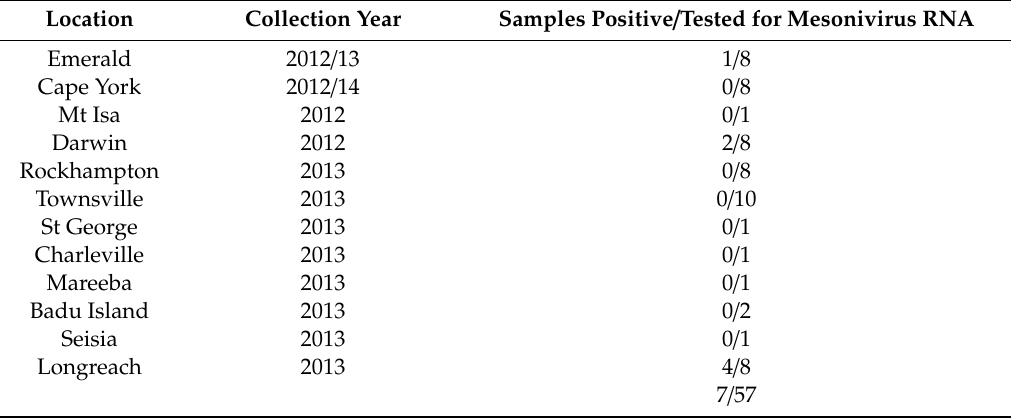
Table 4. Location and collection date of FTA cards tested for mesonivirus RNA by RT-PCR.